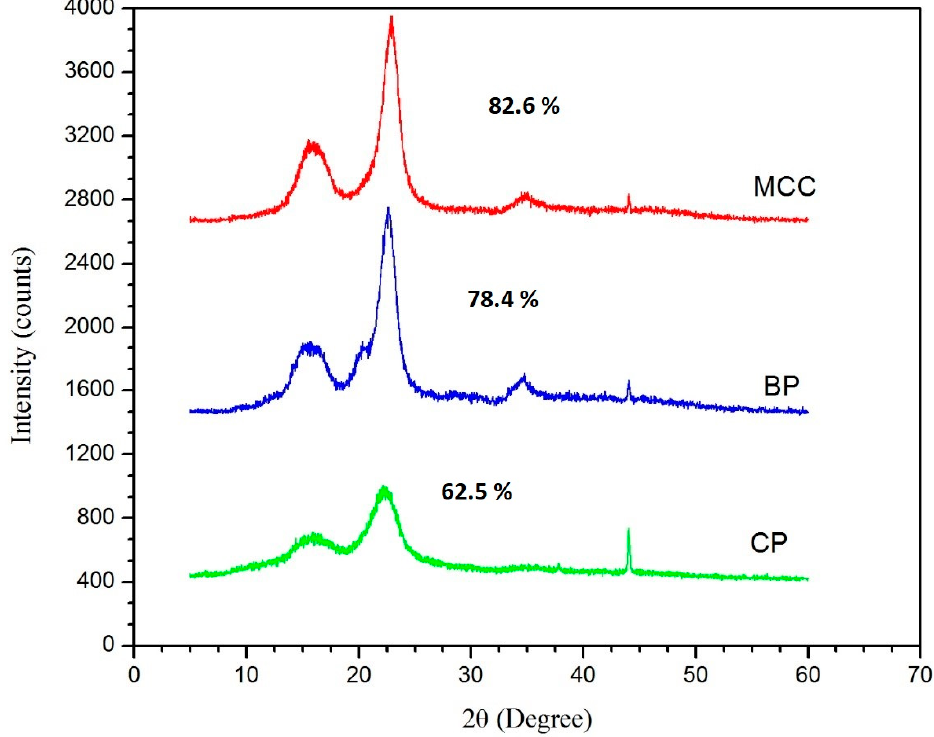
Figure 4. X-ray diffractograms of MCC, B-pulp, and C-PULP samples were taken as reported in the methods section. Furthermore, equation 1 was taken into account for the calculation of crystallinity of intermediate (C-Pulp and B-Pulp) and final isolated sample, MCC.